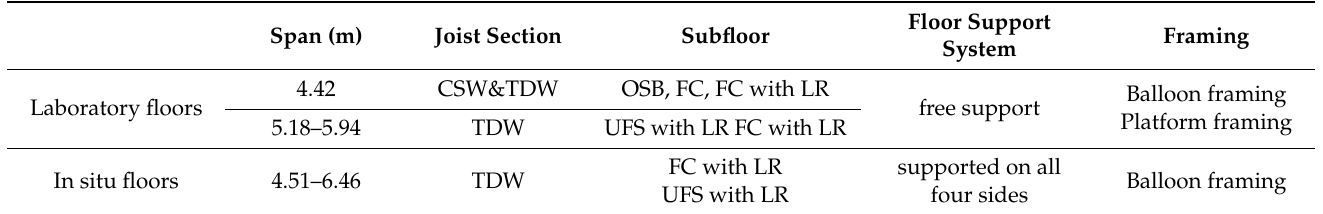
Table 2. Laboratory and in situ construction configuration tested by Parnell et al. [35]. See Figure 3 for a typical cross-section of the floors.